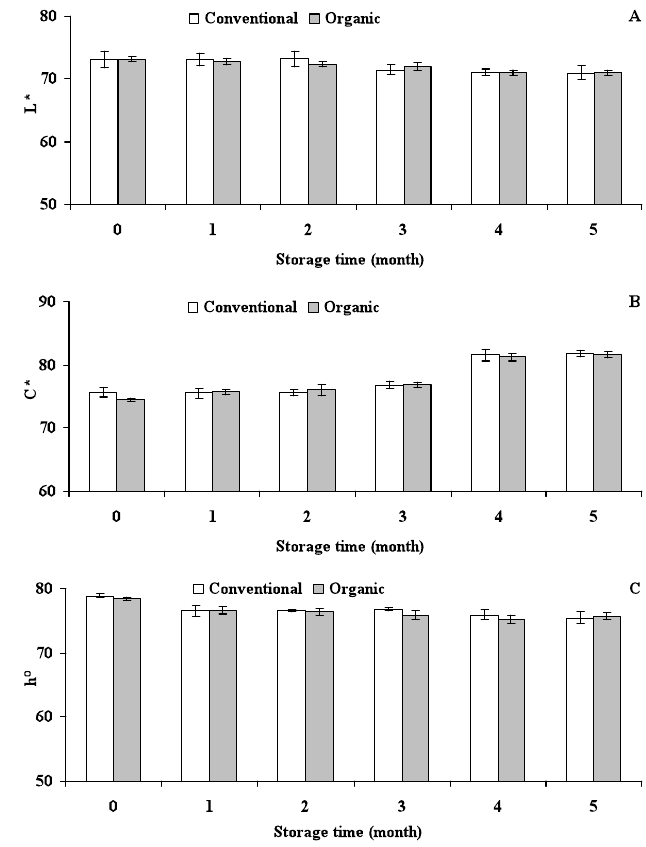
Fig. 2: Changes in rind color L*, C* and h° values of conventionally and organically grown ‘Washington Navel’ oranges during storage at